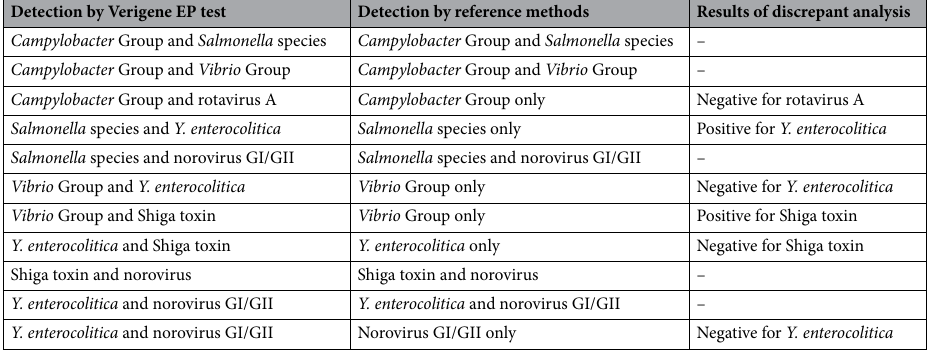
Table 2. Detection of multiple targets by the Verigene Enteric Pathogens Nucleic Acid Test and comparative analysis.